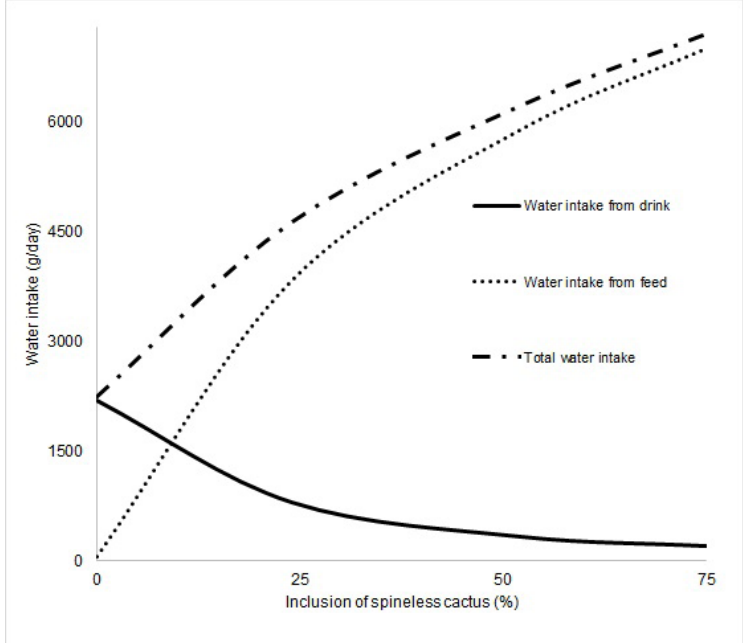
Figure 1. Water intake by lambs fed with increasing levels of spineless cactus inclusion in the diet. Water intake from drink